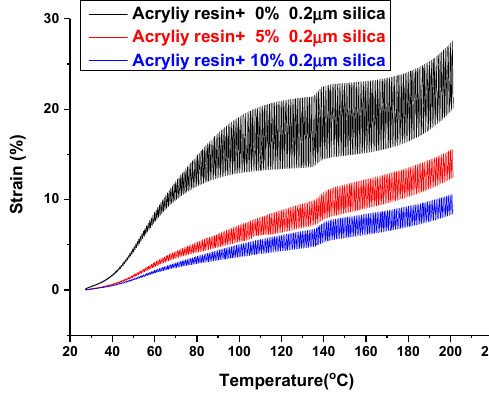
Figure 23. Strain of acrylic based SnBi58 solder ACFs with added silica fillers as a function of temperature.